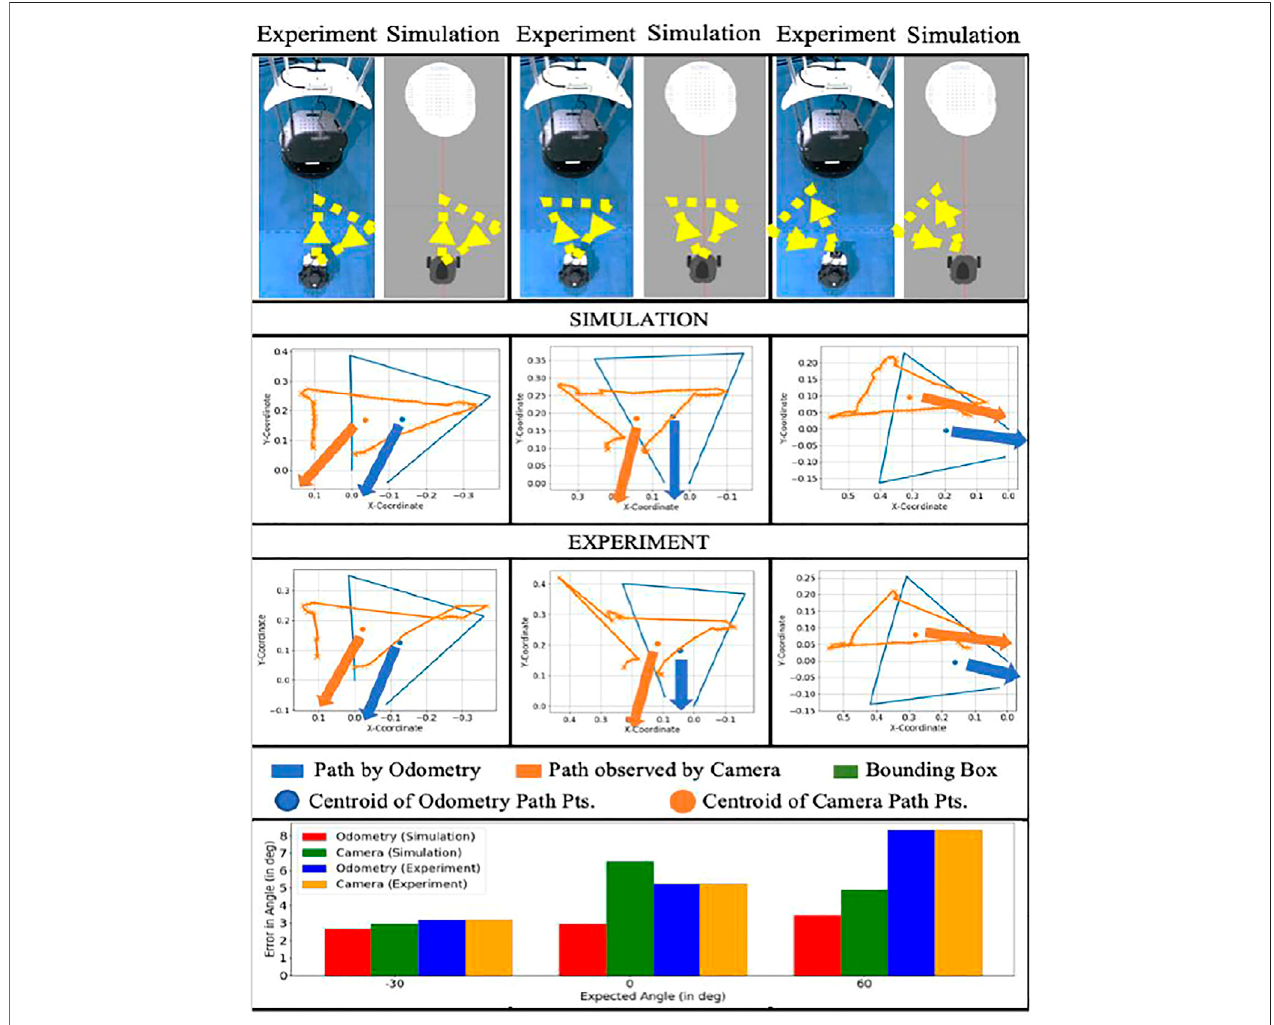
FIGURE 10 | Comparison for few cases of angle orientations and error comparison for odometry and camera perception for simulation and experimental results. The blue and orange arrows indicate the formulated angle. The bar chart depicts the error in the formulated orientation.